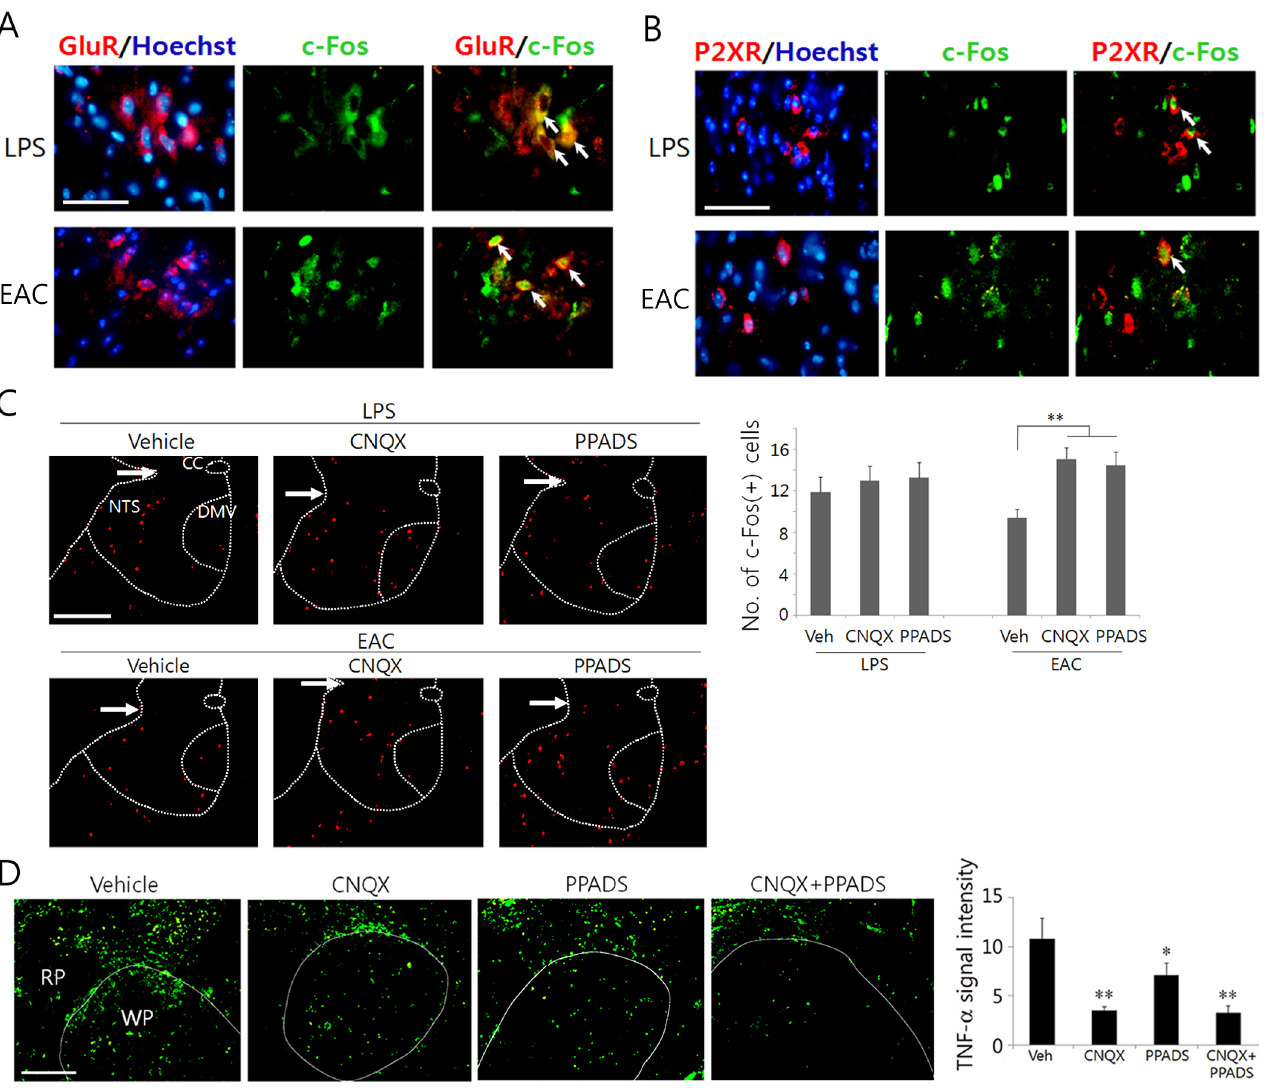
Fig 5. Identification of cells positive to glutaminergic and purinergic receptors and blockade effects of receptors on c-Fos and TNF- α production. Following LPS (180 min later) or EAC (90 min later), transverse sections through the caudal portion of the brainstem were used for immunofluorescence staining for GluR2/3 and c-Fos (A), P2X2 receptor (red) and c-Fos (green), and c-Fos. In (D), animals were treated with LPS and EAC, and drugs were also injected as indicated in the figure. Arrows in (A) and (B) denote the cells coexpressing GluR2/3 and c-Fos and P2X2 and c-Fos respectively. Arrows in (C) denote the approximate NTS boundary between two hemispheres. Quantifications of the protein signals are shown in (C) and (D). Mean ± SEM (n = 4 independent experiment). * p < 0.05 and ** p < 0.01, *** vs. vehicle control (one-way ANOVA). The scale bars in (A-D) are 100 μ